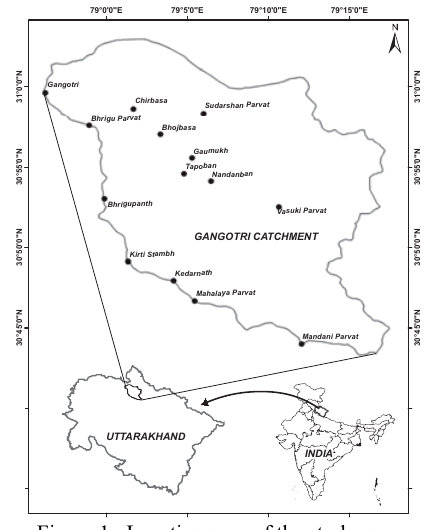
Figure 1. Location map of the study